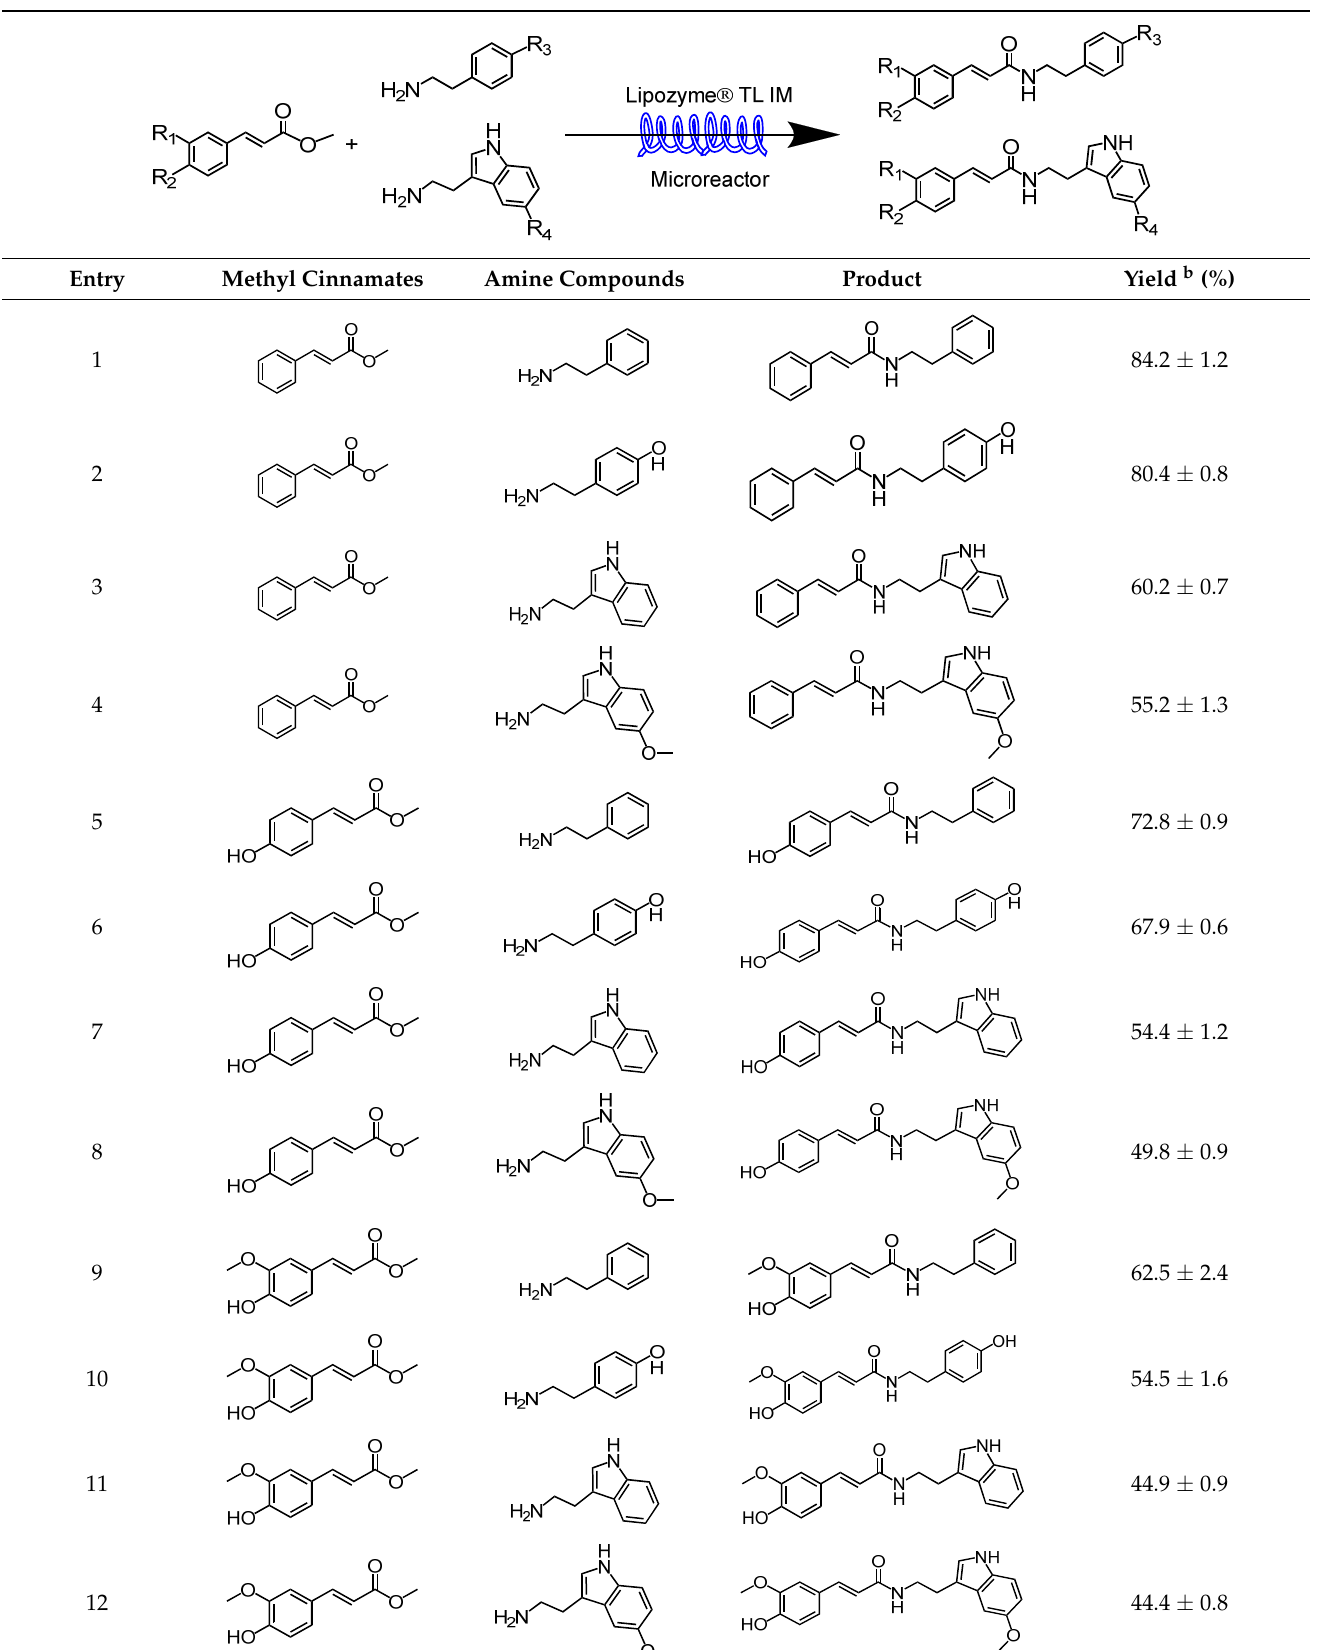
Table 3. Effect of substrate structure on the synthesis of cinnamamide derivatives catalyzed by Lipozyme ® TL IM in continuous-flow microreactors a .